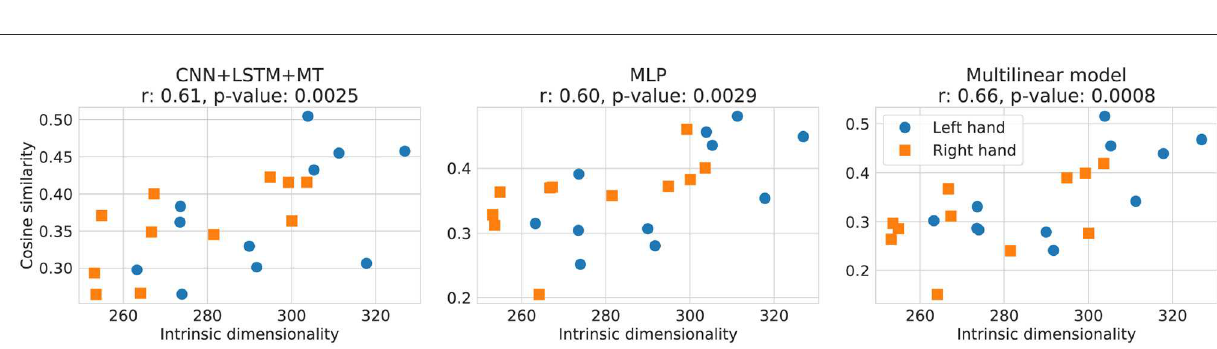
TABLE 3 Parameters of trend lines fitted to the dataset translation results.